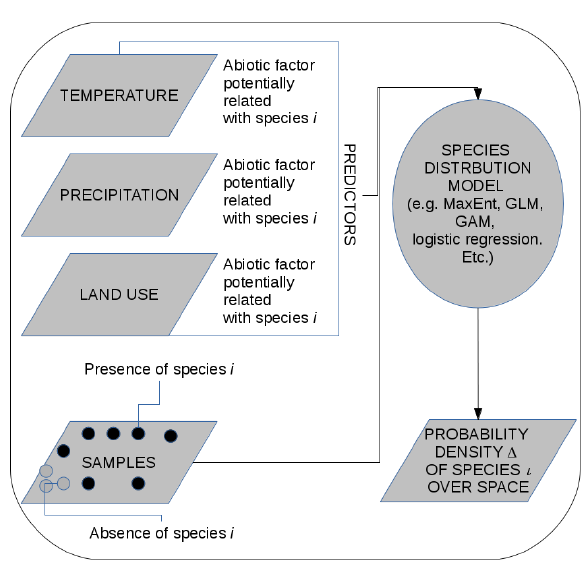
Figure 1: An example of the flow leading to a species distribu- tion map, derived as a probability density function from spatial gridded predictors, mainly in raster but also in vector format, and point data in the